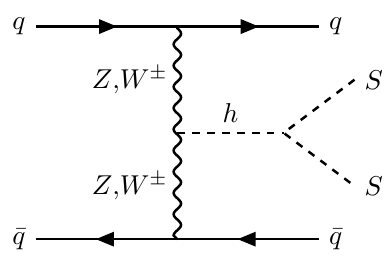
Figure 1 . Feynman diagram for Higgs-portal DM production in VBF at the